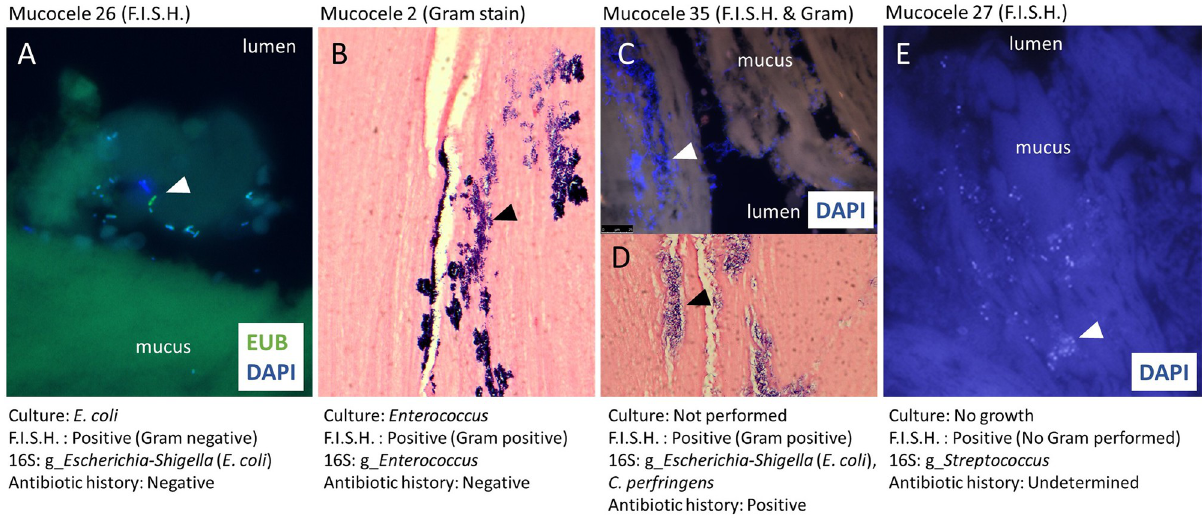
Fig 5. Results of fluorescence in-situ hybridization (F.I.S.H.) for eubacteria and Gram stain of gallbladder mucosa from 4 dogs with mucocele formation and concurrent findings of conventional culture and 16S rRNA gene sequencing of mucus content. Bacteria are indicated by closed arrowhead and visualized by means of positive hybridization with Eub 338—6FAM (green; panel A), Gram stain (panel B and D), or DAPI staining of bacterial nucleic acid (blue; panel A, C, and E).